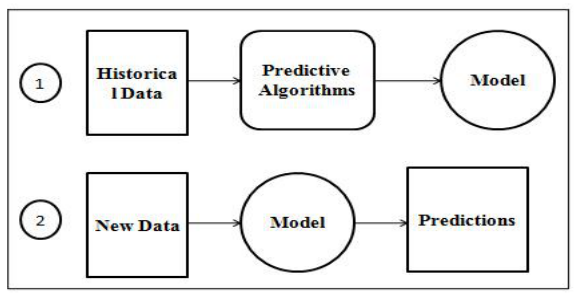
Figure 2. Predictive Analytics